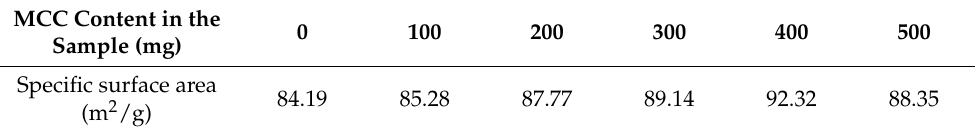
Table 3. Specific surface areas of GA aerogel and GA-MCC-PEI-(1–5) aerogel. MCC Content in